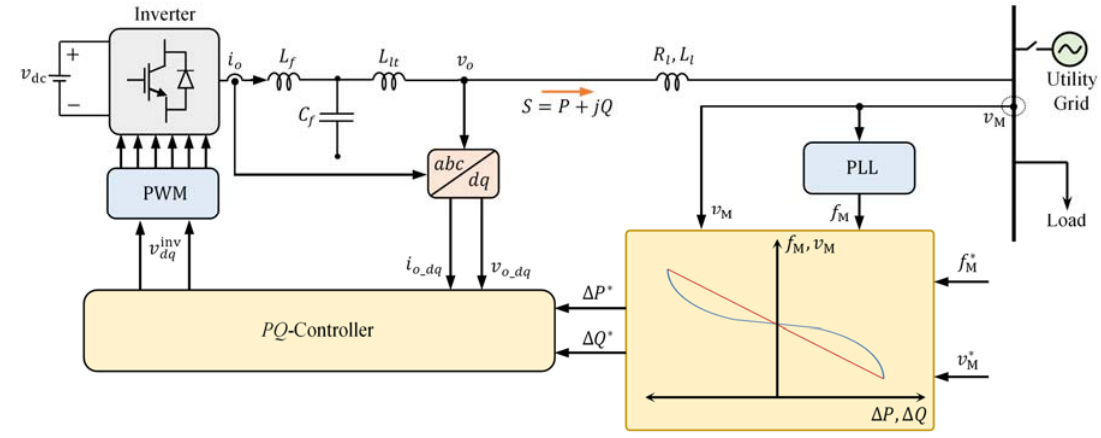
Figure 4. Control block diagram of a PQ ‐ controlled BESS ‐ based inverter equipped with PLE and linear droops.